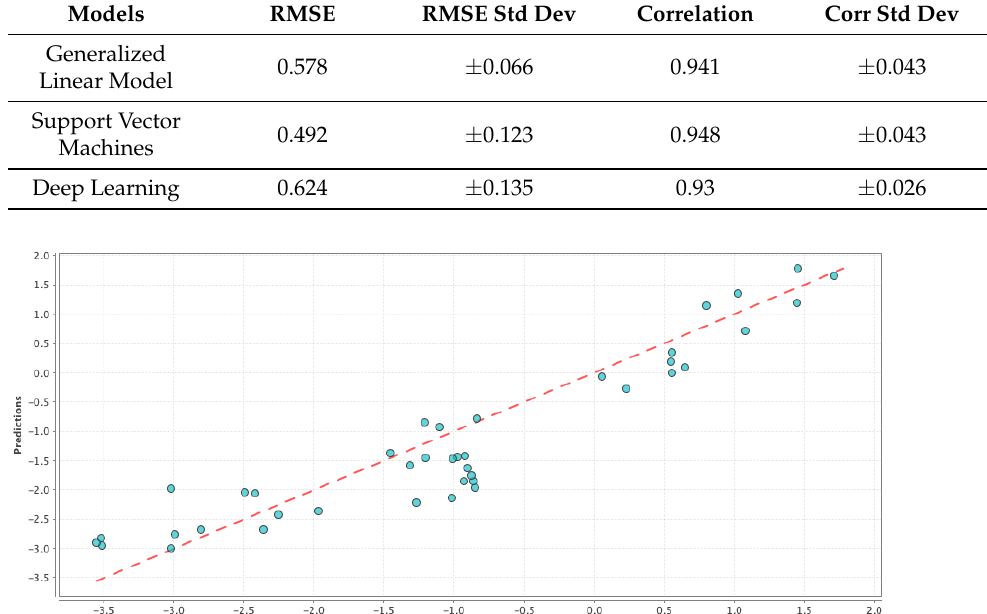
Table 6. Results on Test Set for Generalized Linear Model, Support Vector Machines and Deep Learning for Model 6: D + P + N + 1P + 1N.